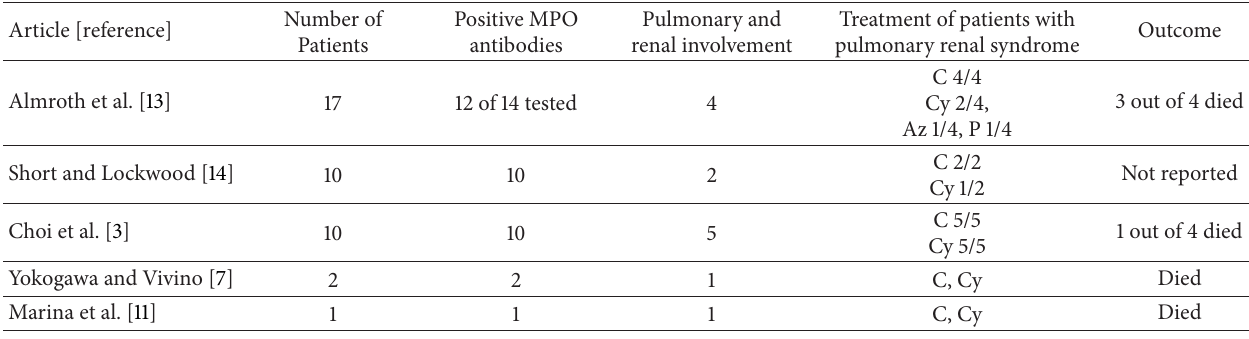
Table 1: Hydralazine-induced ANCA vasculitis—patients with pulmonary renal syndrome, treatment, and